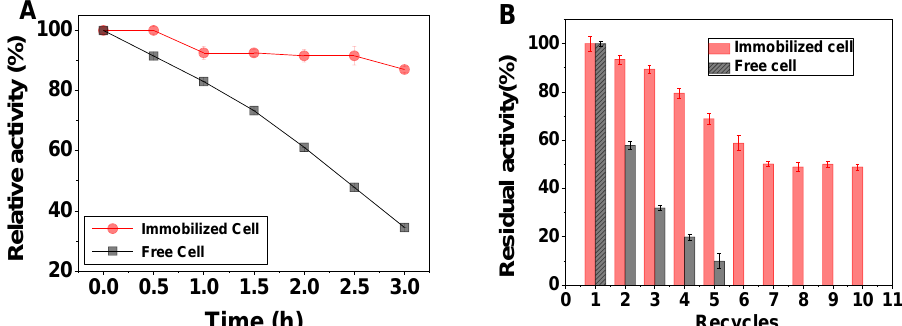
Figure 5. Thermal stability and reusability. ( A ) Thermal stability of the free and immobilized cells. ( B ) Reusability of the immobilized cells. All the experiments were repeated three times, and the standard deviation was calculated and presented as error bars.